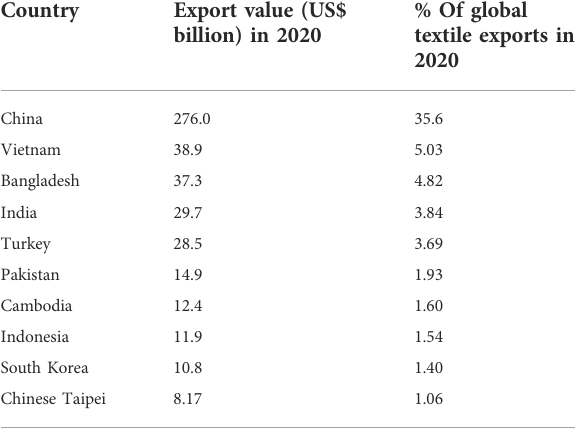
TABLE 1 Top 10 textile exporting countries